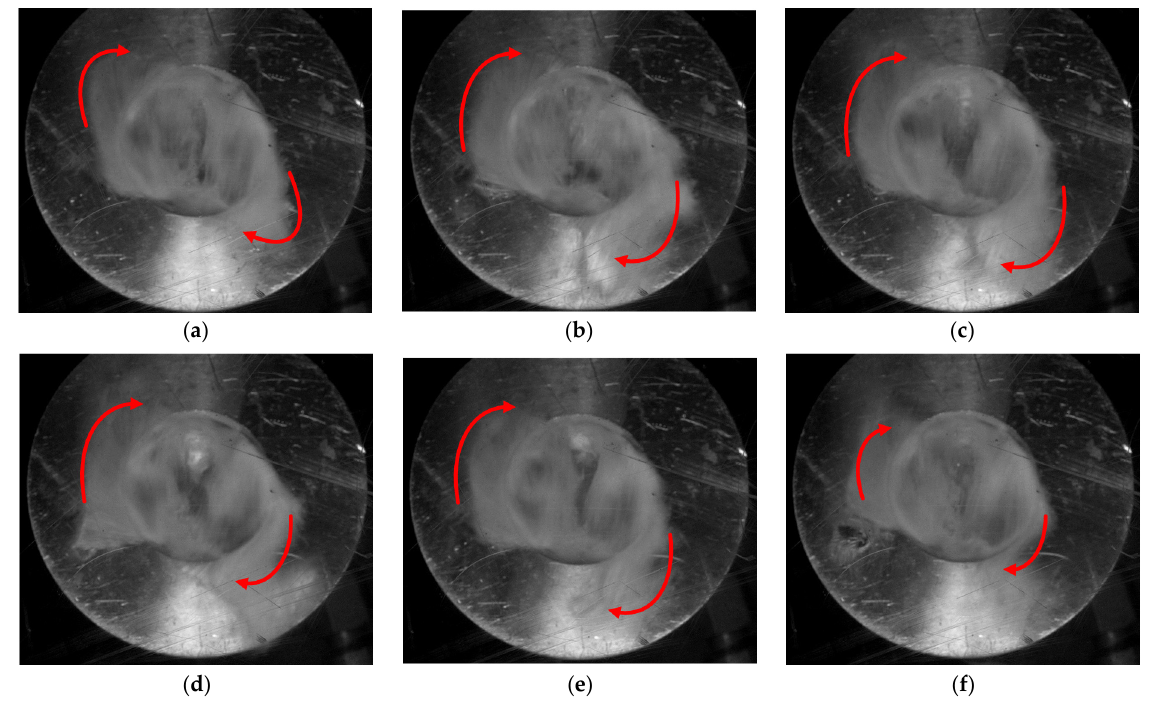
Figure 33. When inlet pressure = 15 MPa, gap = 1.5 mm, the photos of radial and axial fluctuations of fluid flow of suction cup- θ 20 at time ( a ) 5 ms, ( b ) 9.6 ms, ( c ) 14.2 ms, ( d ) 18.8 ms, ( e ) 23.4 ms, and ( f ) 28 ms. (The red arrows indicate the flow direction of fluid).